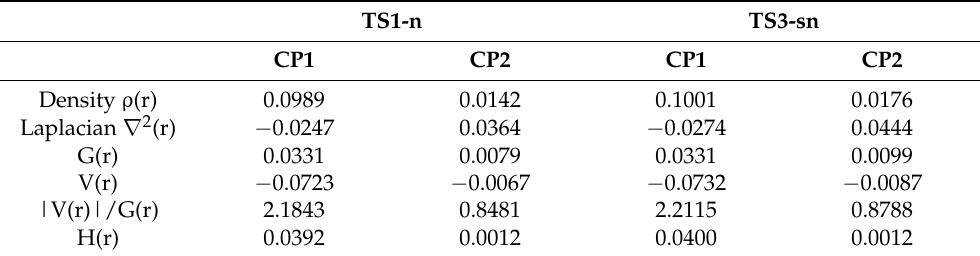
Figure 7. (i) ELF basin attractor positions together with the most relevant valence basin populations at TS1-n and TS3-sn , and (ii) representations of the contour line maps of Laplacian ∇ 2 (r) of the electron density at TS1-n and TS3-sn . The CP1 and CP2 critical points are marked in the representations. Table 6. AIM parameters, in au, of (3, − 1) CPs at TS1-n and TS3-sn in the regions associated with the C − C and C − N single bond